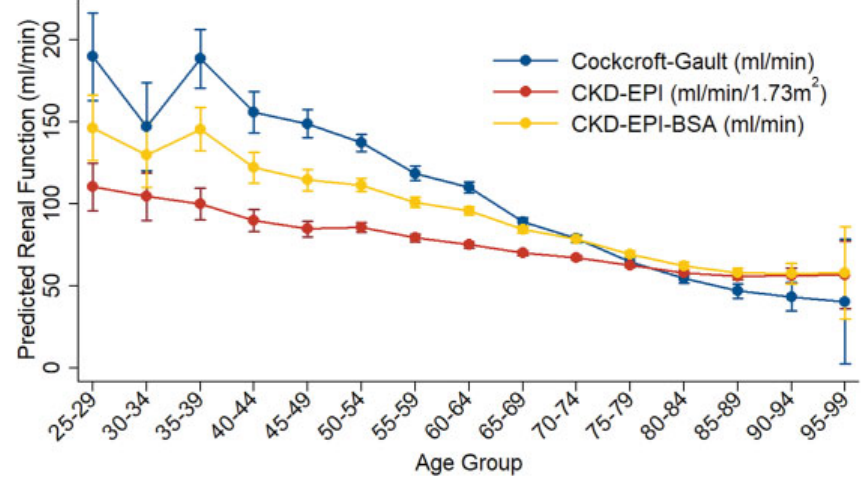
Fig. 1 Adjusted predictions (ANOVA) of baseline renal function with 95% CI for patients dispensed dabigatran etexilate by the Cockcroft – Gault